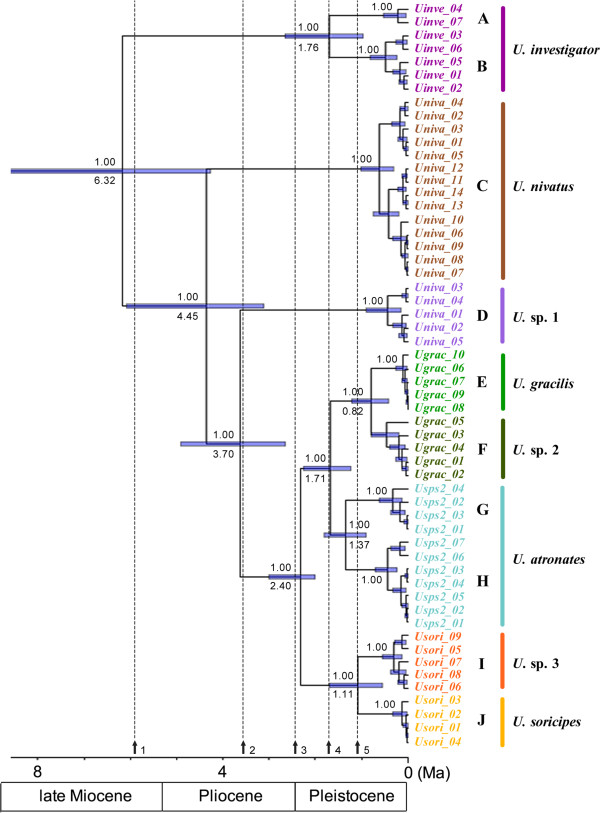
Maximum credibility ultrametric tree of Uropsilus based on mitochondrial-nuclear concatenated data. The numbers above branches are the Bayesian posterior probabilities and the numbers under the branches represent the median divergence times. The node bars indicate the 95% interval confidence for the divergence time estimates. The five vertical lines represent the major historical events in the diversification of Uropsilus: 1) 5.93 Ma, Messinian salinity crisis [27]; 2) 3.6 Ma, strongest uplift of the QTP [28,29]; 3) 2.4 Ma, modern Asian monsoon system began and Pleistocene glaciation started [30,31]; 4) 1.8 Ma, uplift of the QTP [32]; 5) 1.1 Ma, uplift of QTP [28,32].